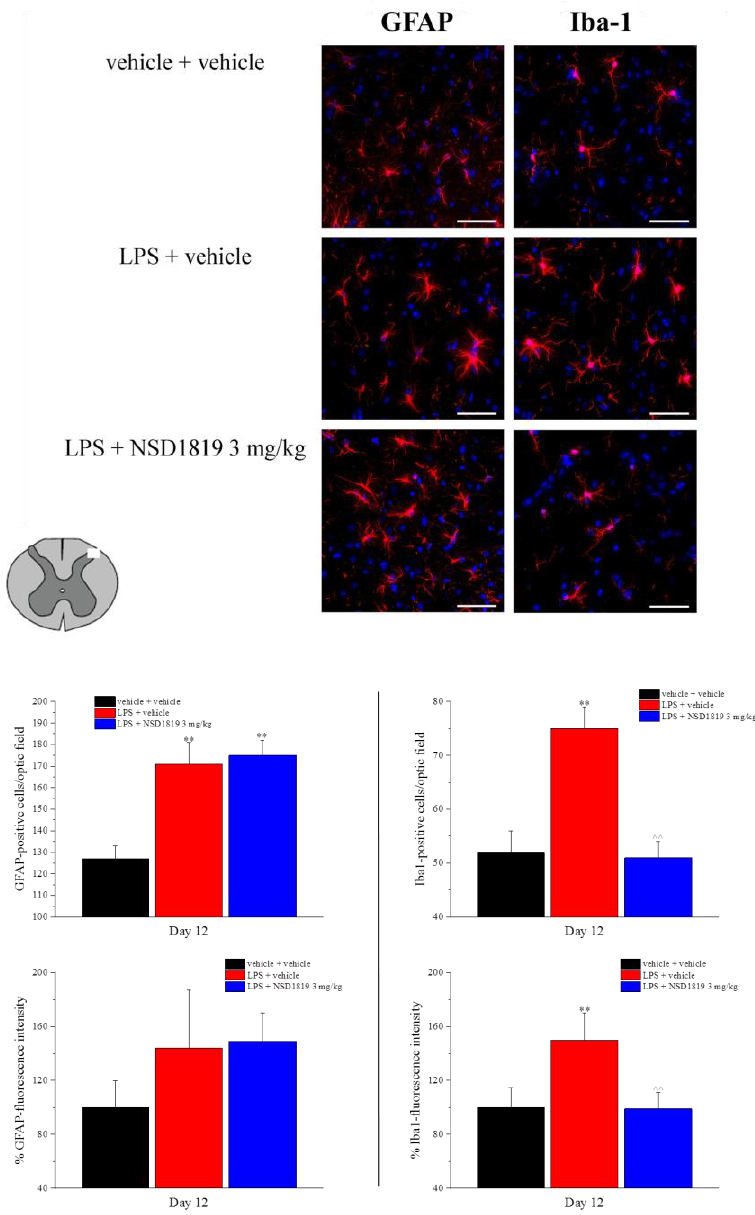
positive cells and the % of Iba-1 fluorescence intensity were significantly reduced in LPS + NSD1819 treated animals in comparison to the LPS + vehicle group (Figure 6). Nevertheless, the upregulation of GFAP-positive cells was not modified by the compound.